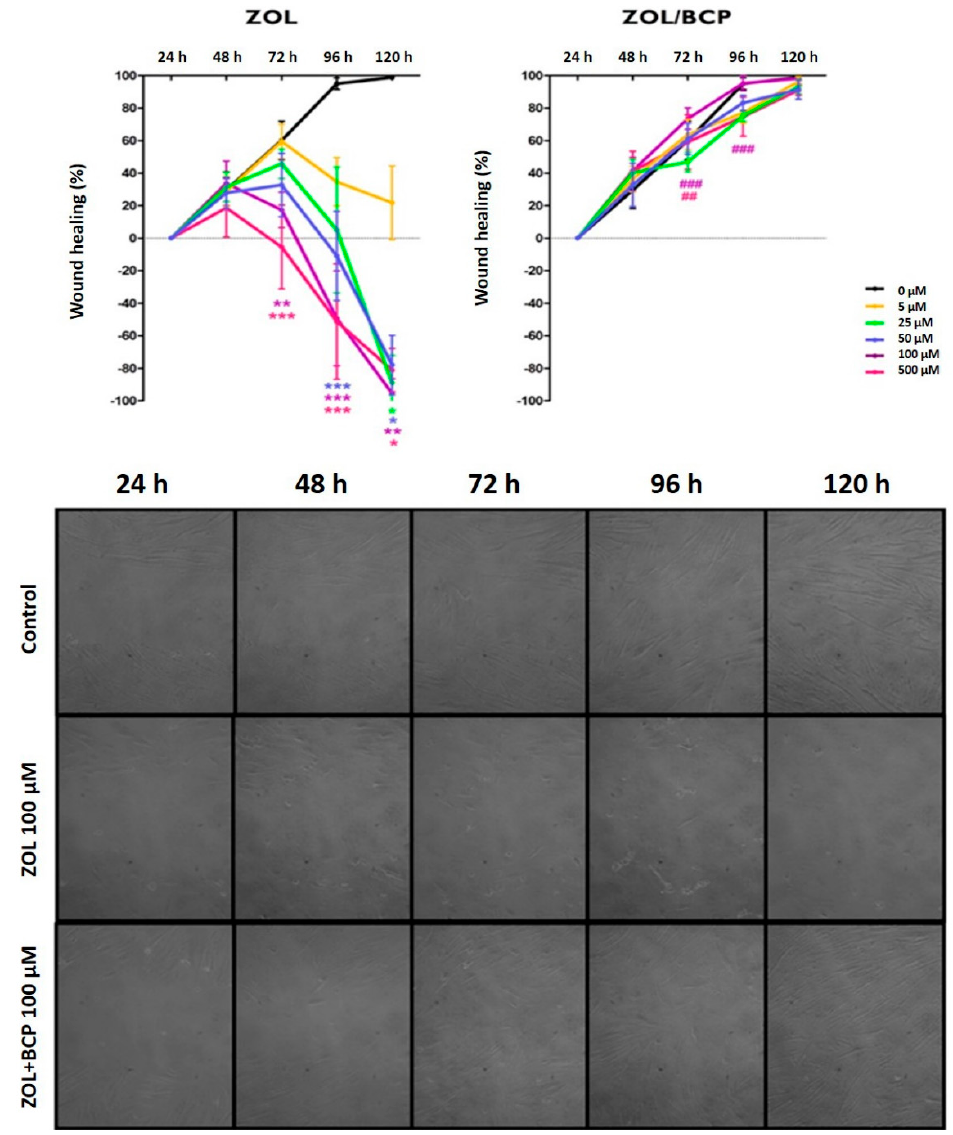
Figure 5. The migration of HGF up to 120 h, comparing cell cultures under treatment with ZOL (left) and with ZOL/BCP (right). The results represent the mean and standard deviation of at least three tests. Significant differences are represented with *, where * means p < 0.05, ** means p < 0.01, and *** means p < 0.001. The images in the bottom of the panel are representative microphotographs of control cell cultures and cell cultures submitted to ZOL and to ZOL/BCP for 24 h, 48 h, 72 h, 96 h and 120 h. However, in cultures subjected to ZOL, confluence recovery is compromised proportionally to concentration and is significant for higher concentrations. Thus, for the concentration of 100 μ M, there was a lower percentage of HGF migration after 72 h ( p = 0.004), 96 h ( p < 0.001), and 120 h ( p = 0.003), and, for the concentration of 500 μ M, the percentage was lower for the same time points ( p <